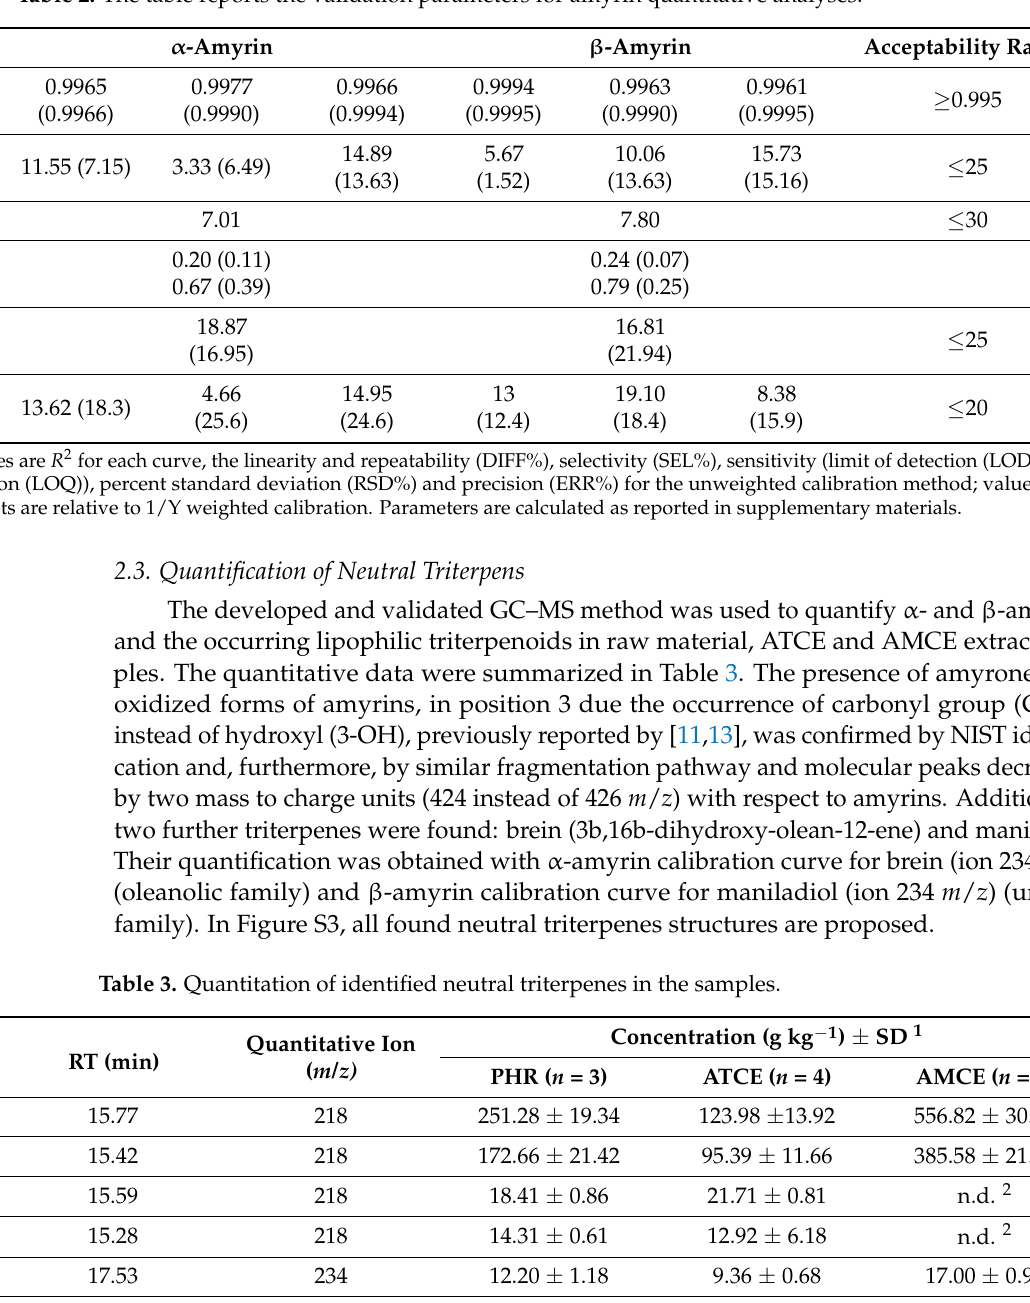
Table 2. The table reports the validation parameters for amyrin quantitative analyses.